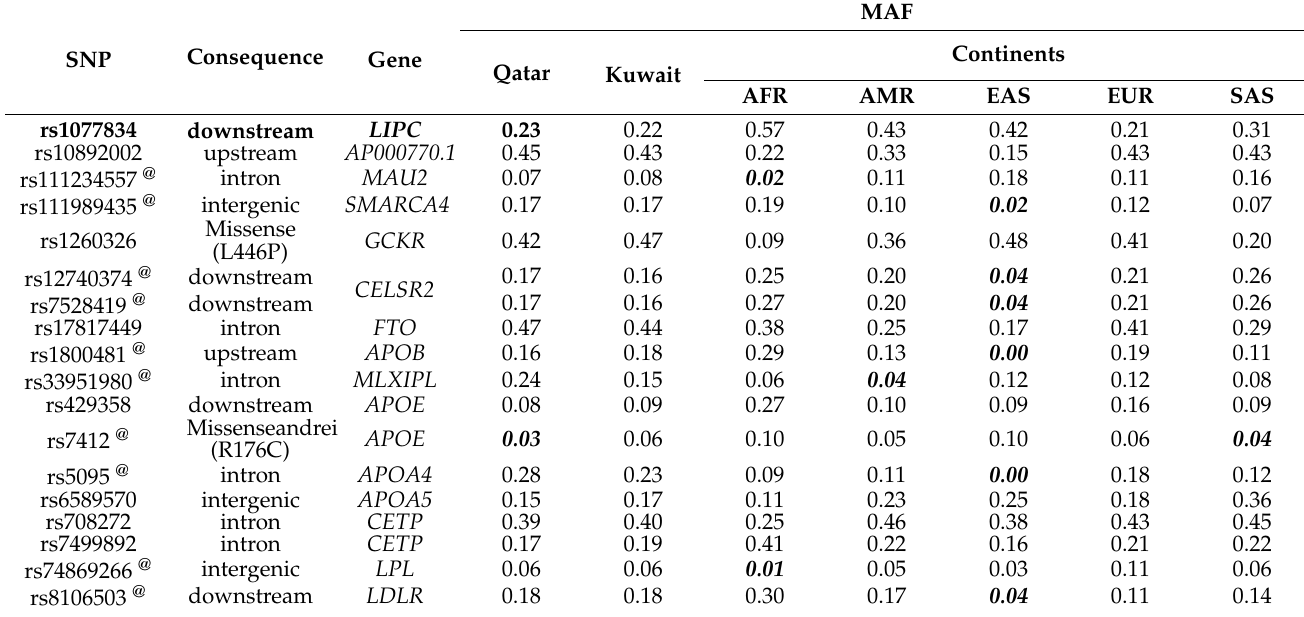
Table 2. List of SNPs forming GWA-identified association signals, for lipid traits, generalizable to both the cohorts of Kuwaiti and Qatari